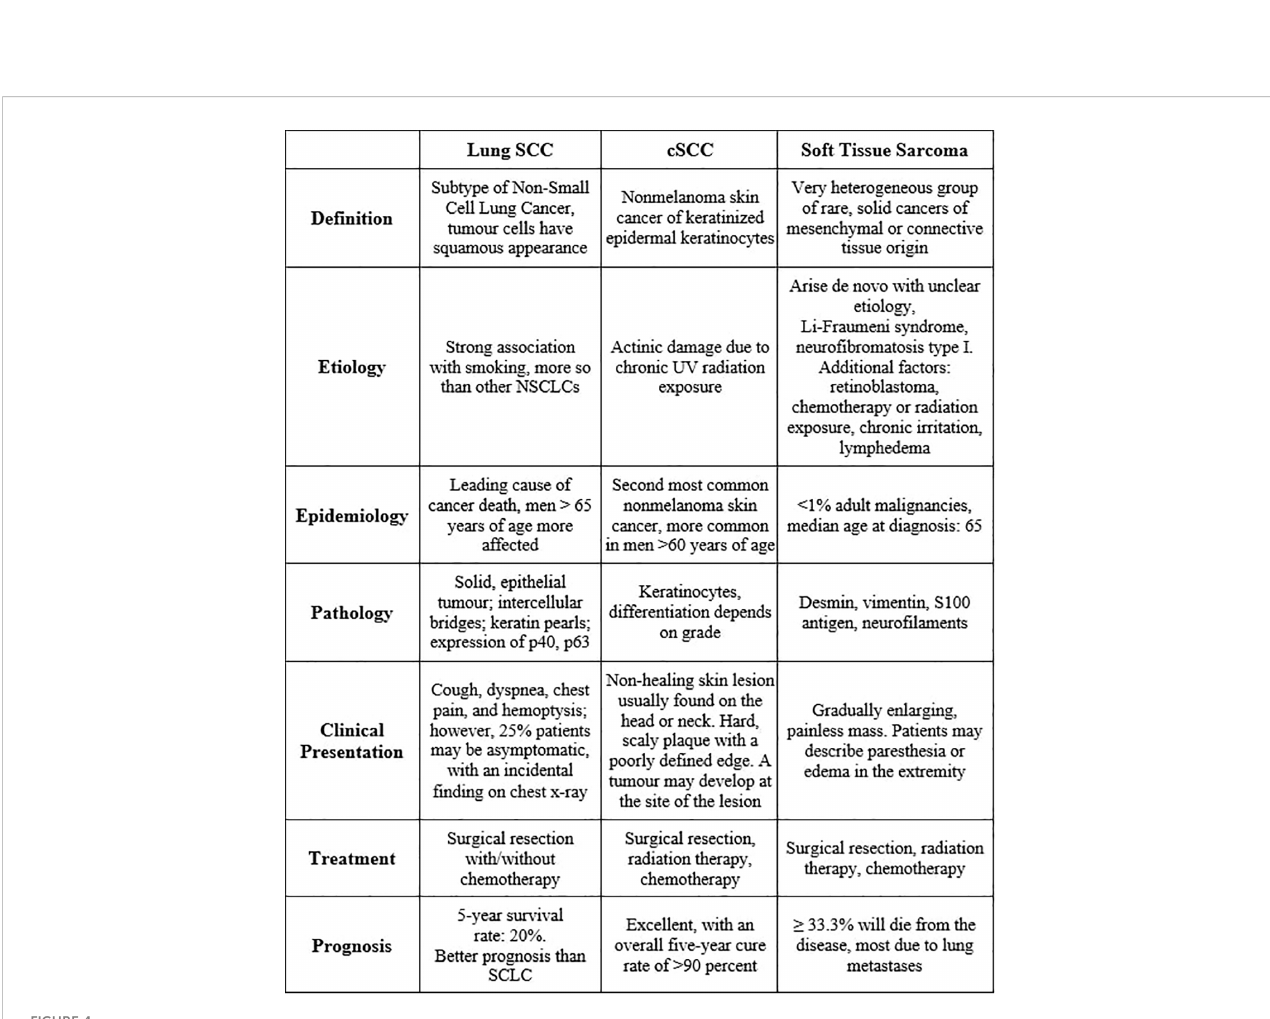
FIGURE 3 Transthoracic Echocardiogram showing a large echogenic mass in the Left Atrium, in the parasternal long-axis (A) and apical multi-chamber views (B – D) , July 26, 2022, with measures estimating a mass size of 2.6-2.9 cm x 2.0-2.4 cm.